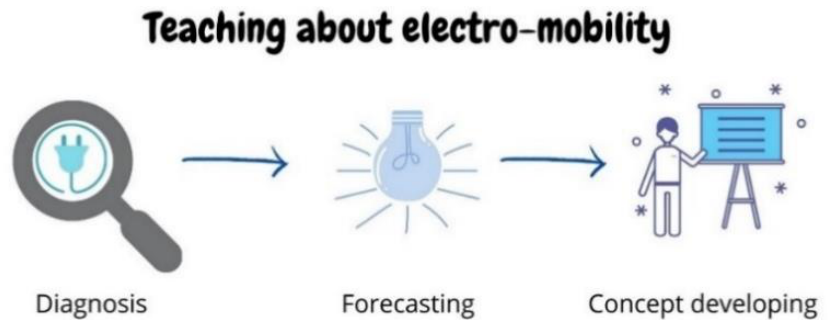
Figure 1. Structure of the education process in the field of electric mobility based on the three main pillars of pedagogy.